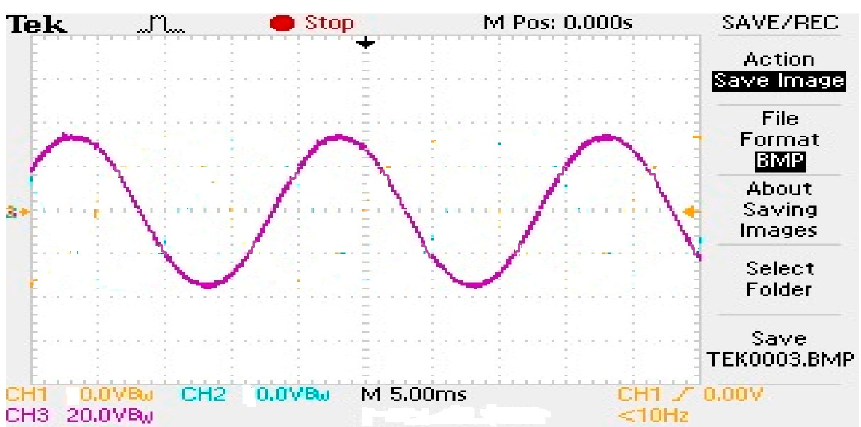
Figure 21. Output voltage of dual active bridge-based boost inverter.